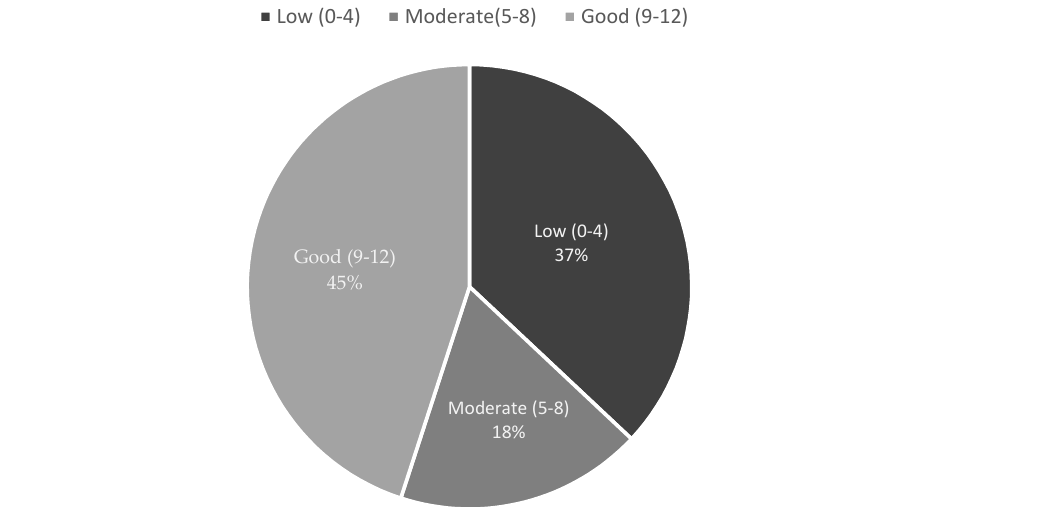
Figure 4. The ability to manage REF among participants. Table 2. Relation between physicians’ characteristics and their ability to manage